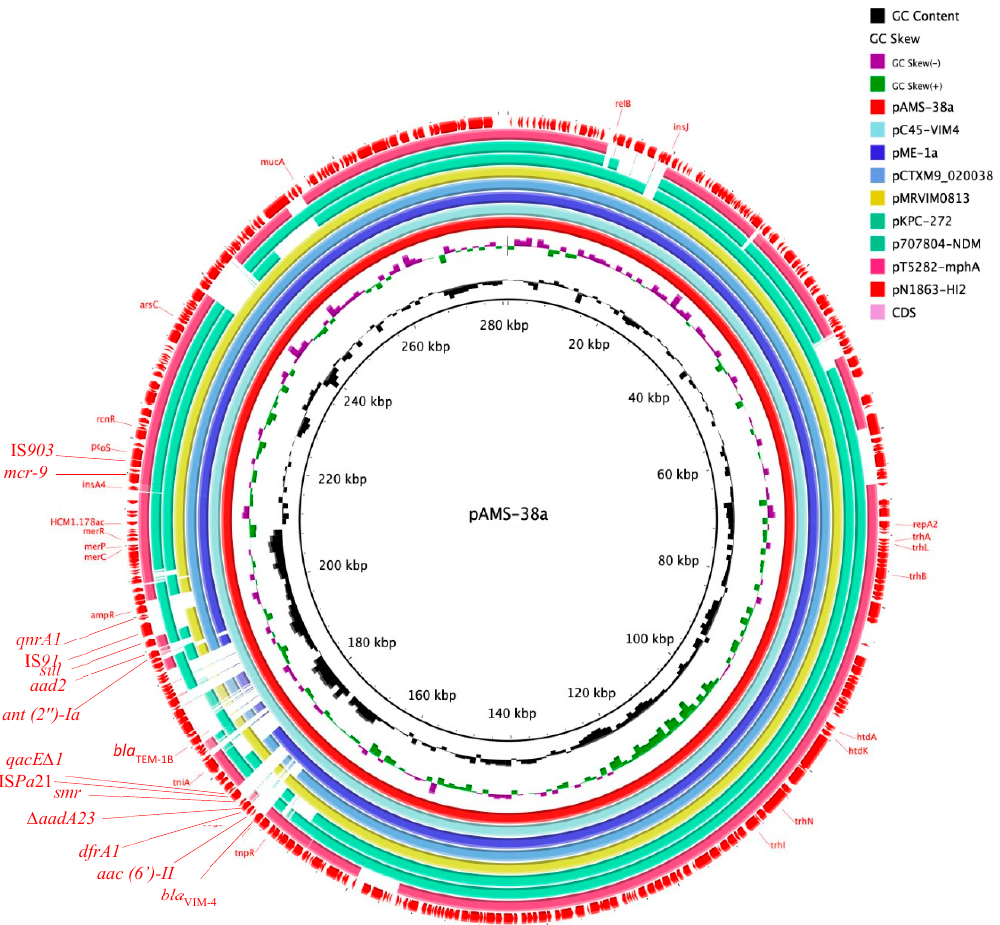
Figure 1. Plasmid structure of mcr-9 / IncHI2 plasmids. The whole sequence of pAMS-38a was used as the reference. Genes and open reading frames (ORFs) are shown as arrows with their transcriptional orientations indicated by arrowheads. This figure was generated using the BRIG tool [17], and the plasmids were included in the following order: pAMS-38a (identified in this study), pC45-VIM4 (LT991958), pME-1a (CP041734), pCTXM9_020038 (CP031724), pMRVIM0813 (KP975077), pKPC-272